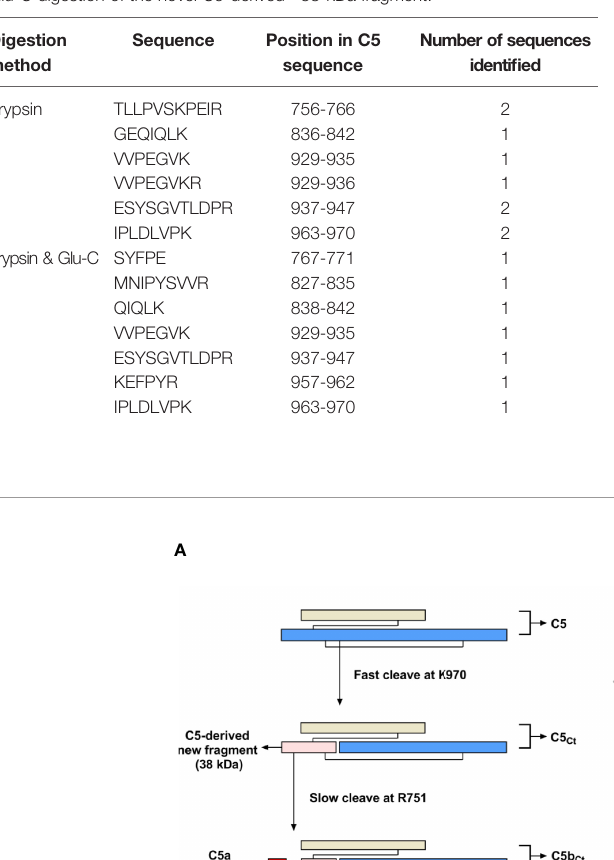
TABLE 1 | Sequences of peptides identi fi ed by trypsin digestion or trypsin and Glu-C digestion of the novel C5-derived ~38-kDa fragment.